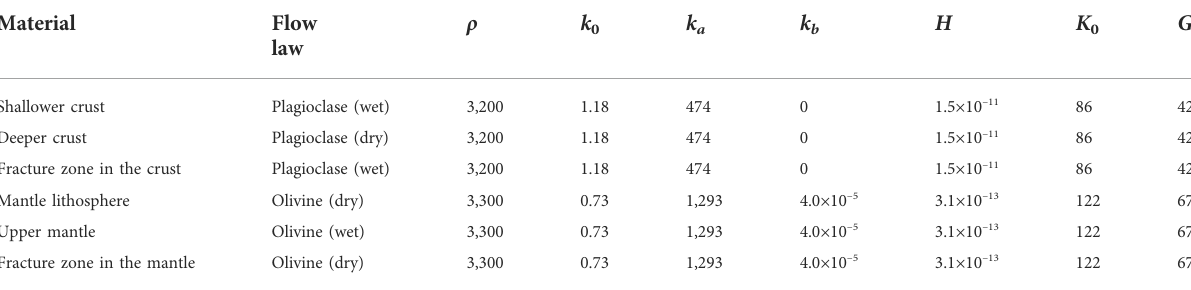
TABLE 2 Physical parameters used in the numerical simulation.